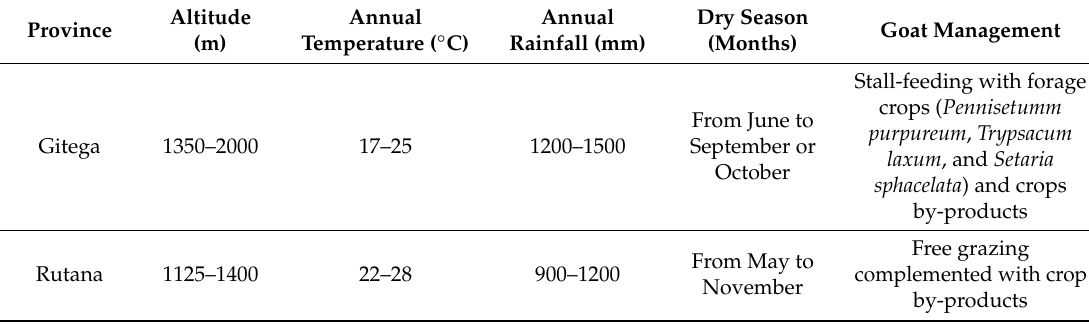
Table 1. Characteristics of the climate and goat management of the study